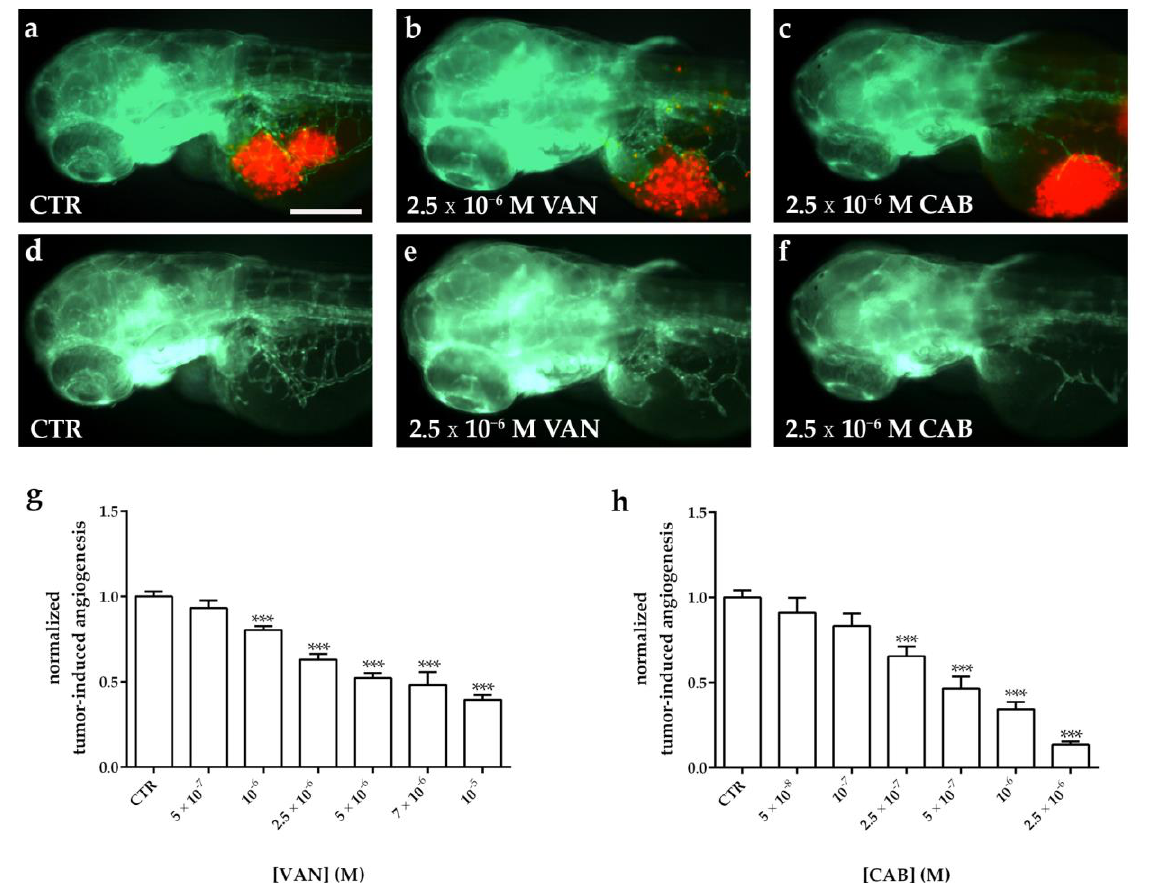
Figure 6. Effect of vandetanib (VAN) and cabozantinib (CAB) treatments on tumor-induced angiogenesis after TT cell xenograft in zebrafish embryos. Representative fluorescence images of 72 hpf Tg(fli1a:EGFP) y1 zebrafish embryos implanted at 48 hpf with TT cells and subsequently treated for 24 h with dimethyl sulfoxide (DMSO) ( a , d ), VAN ( b , e ) and CAB ( c , f ). The red channel, corresponding to TT cells, was omitted in panels d, e, and f to highlight the tumor-induced microvascular network. Grafted larvae showed vessels in green that sprout from the sub-intestinal vein (SIV) toward the xenograft. Quantification of tumor-induced angiogenesis in TT-injected Tg(fli1a:EGFP) y1 embryos after 24 h of VAN ( g ) and CAB ( h ) treatments at different concentrations. Control (CTR) values have been set to 1.0. Graphed values represent the mean ± S.E.M. *** p < 0.001 versus CTR. Embryos are shown anterior to the left. Scale bar: 100 µm.